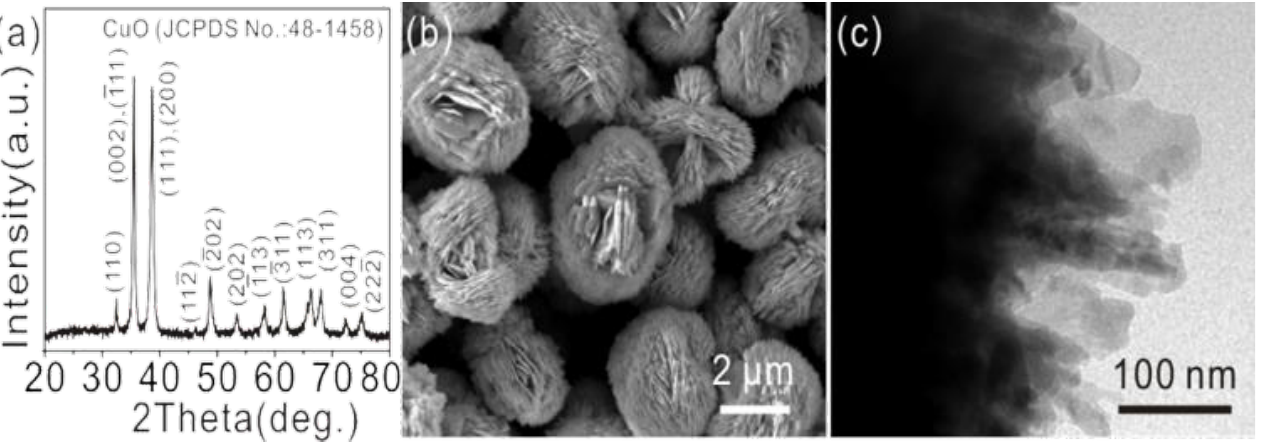
Figure 3. ( a ) X-ray diffractometer pattern, ( b ) SEM, and ( c ) TEM images of the hierarchical CuO microspheres assembled from nano-sheets.